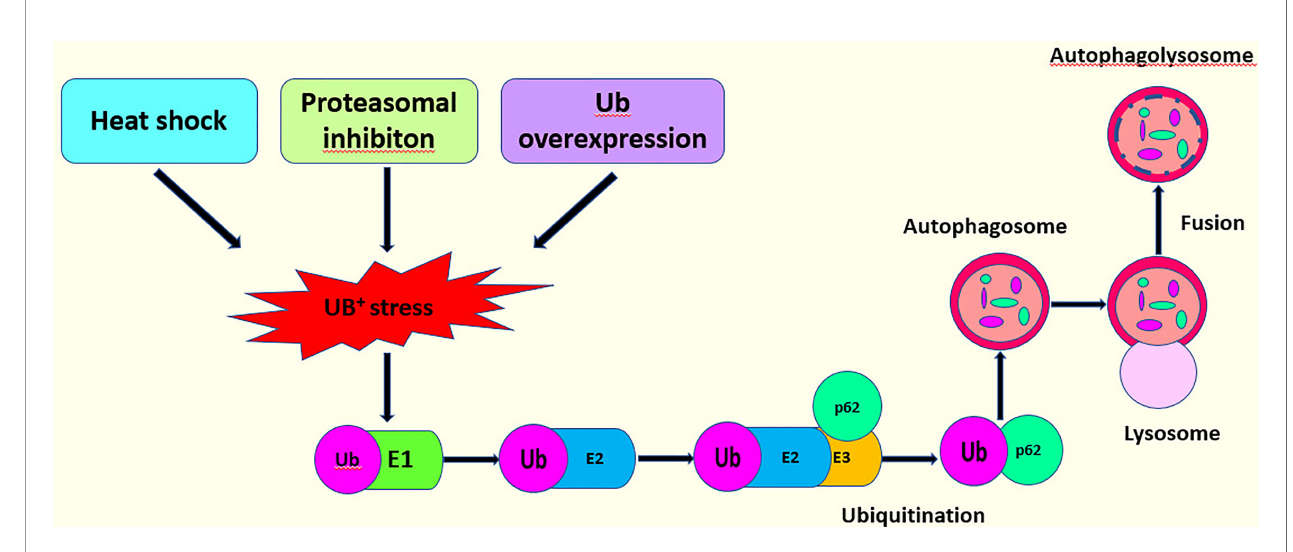
FIGURE 6 | This model describes the interaction of the p62 signaling pathway with the UPS to activate